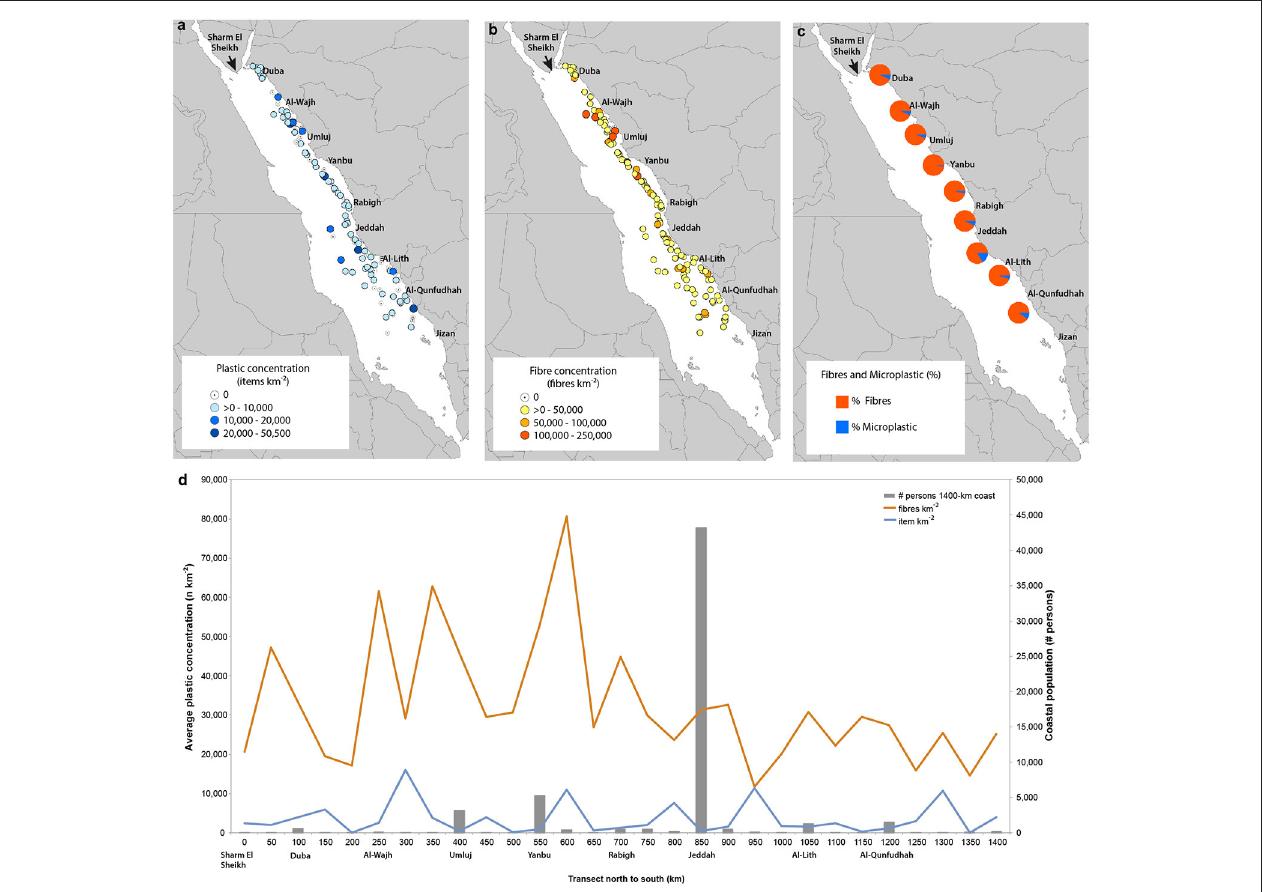
FIGURE 2 | Concentration of plastic fragments (A) and possible plastic fibers (B) in the 120 sampling sites. Average percentage of plastic fragments and possible plastic fibers along the Red Sea transect (C) . Coastal population (gray bars), plastic concentrations (blue line), and possible plastic fibers (orange line) in relation to the linear distance from Sharm El Sheikh (0km), at the northernmost part of the Red Sea (D) .